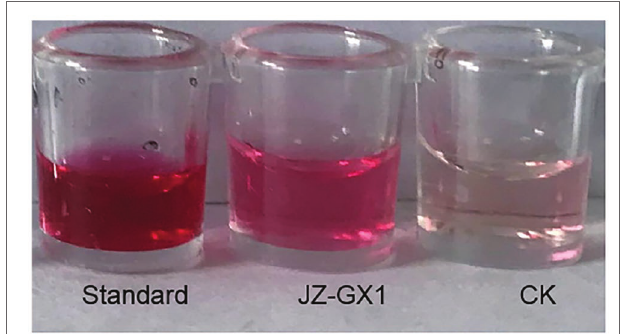
FIGURE 8 | Determination of the 2,3-butanediol production ability of R. aquatilis JZ-GX1. (standard: 2,3-butanediol standard; JZ-GX1: JZ-GX1 fermentation solution; CK: H2O).